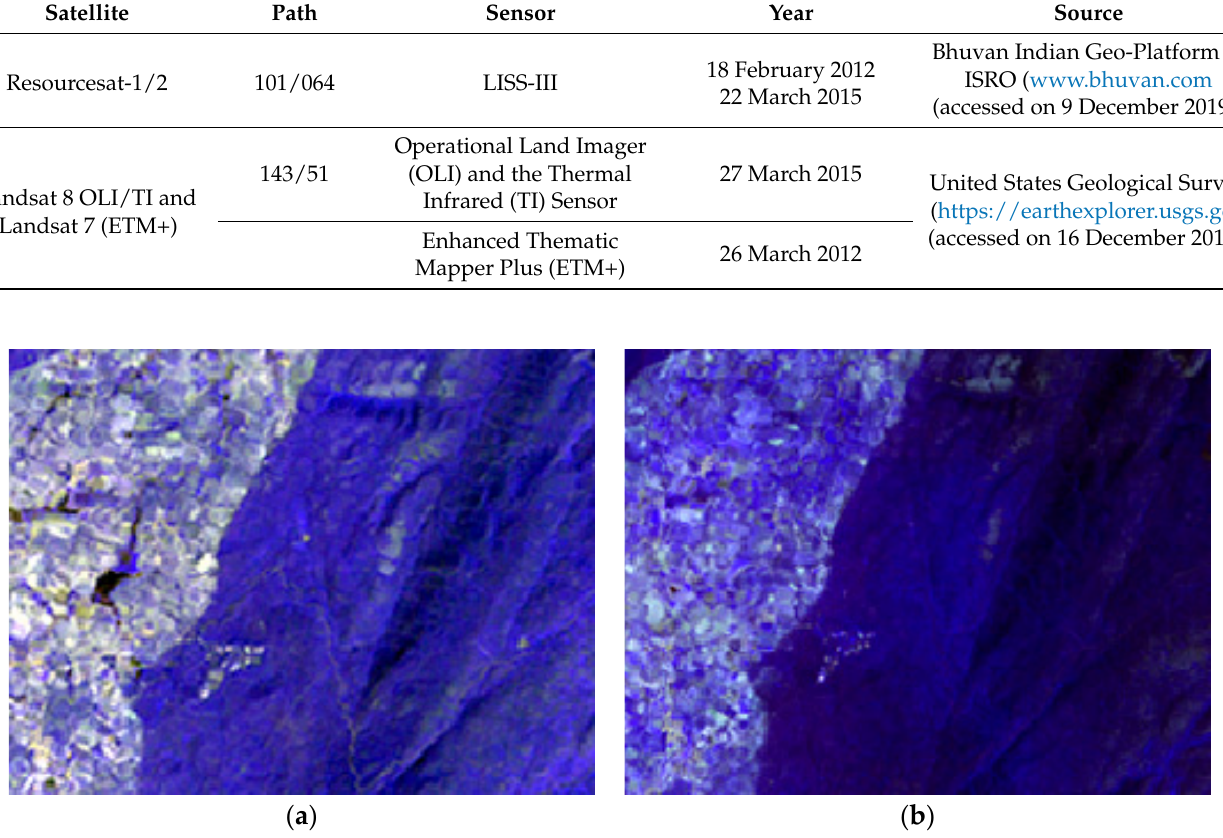
Figure 4. Preprocessed Landsat RED bands of Javadi Hill for the years ( a ) 2012 and ( b ) 2015.